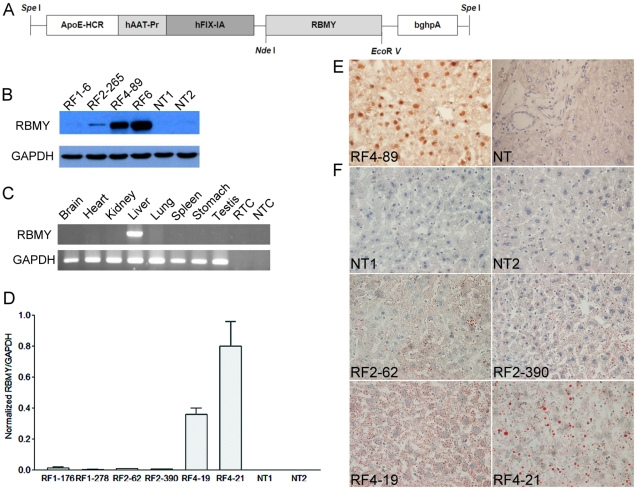
Characterization of RBMY transgenic mice.(A) Genetic map of the 4.2 kb RBMY transgene, including a hepatic locus control region from the apolipoprotein E gene (ApoE-HCR), liver-specific α1-antitrypsin promoter (hAAt-Pr), truncated factor IX intron (hFIX-IA), and bovine growth hormone polyadenylation signal (bghpA). (B) Western blot analysis of RBMY prepared from the livers of individual transgenic (RF1-6, RF2-265, RF4-89, RF6) and control (NT1, NT2) mice. (C) Liver-specific expression of RBMY in transgenic mice by RT-PCR using GAPDH as an internal control. Reactions without template RNA (RTC) or cDNA (NTC) were negative controls. (D) Expression of RBMY in transgenic (RF1-176, RF1-278, RF2-62, RF2-390, RF4-19, RF4-21) and control (NT1, NT2) mice by quantitative RT-PCR. (E) Immuno-histochemical staining of transgenic (RF4-89) and control (NT) mice liver tissues for RBMY. Transgenic mouse showed nuclear staining for RBMY (×400). (F) Oil red staining showed hepatic fatty changes in control mice (NT1 and NT2), low RBMY (RF2-62 and RF2-390) and high RBMY (RF4-19 and RF4-21) transgenic mice (×400).